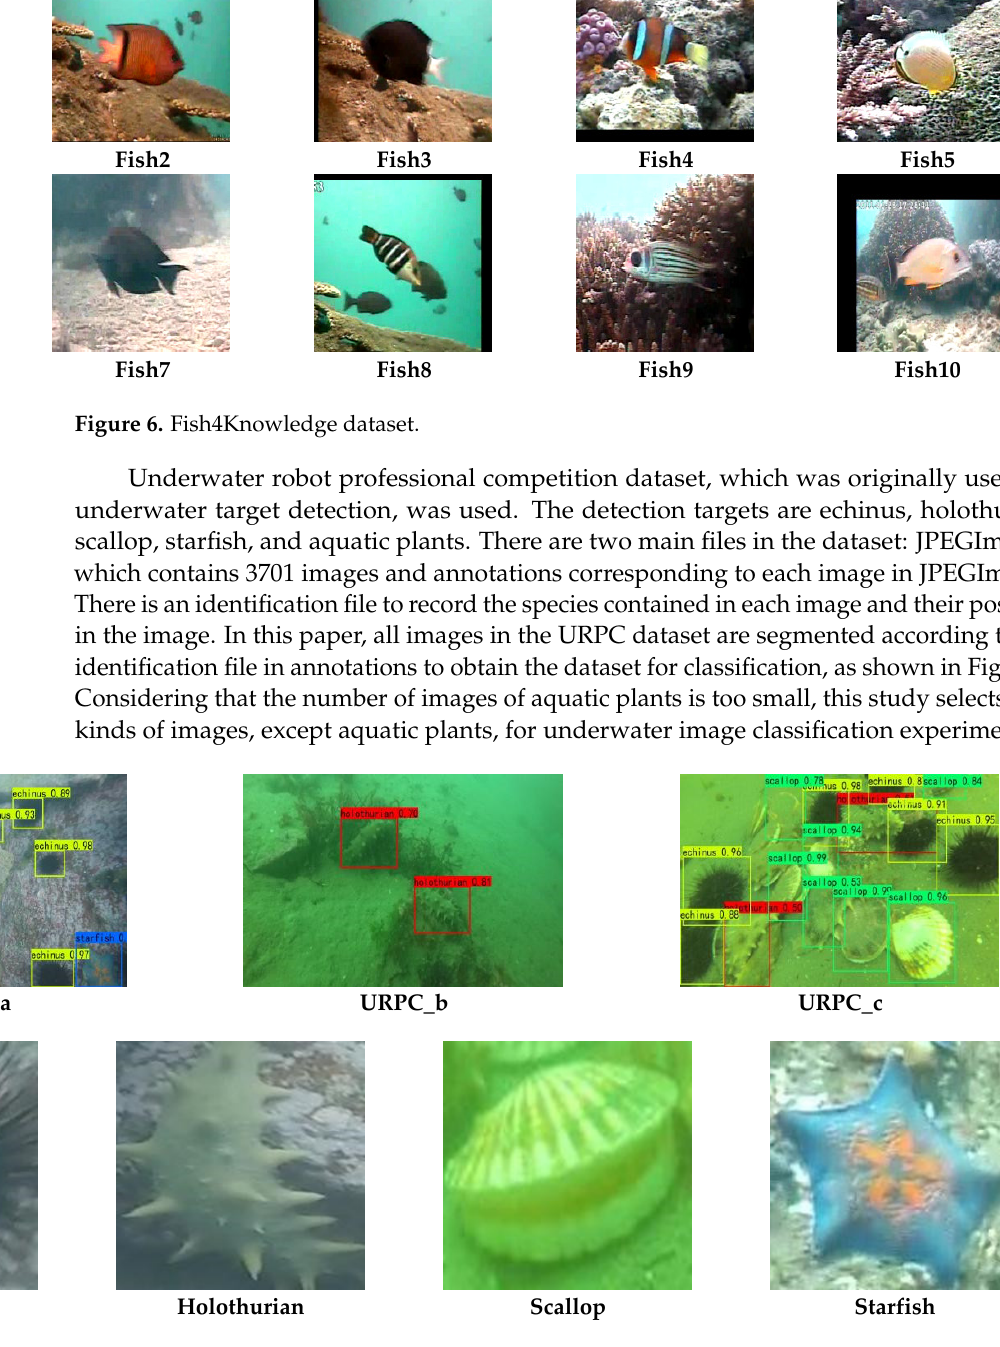
Figure 7. URPC dataset and new classification dataset after segmenting.